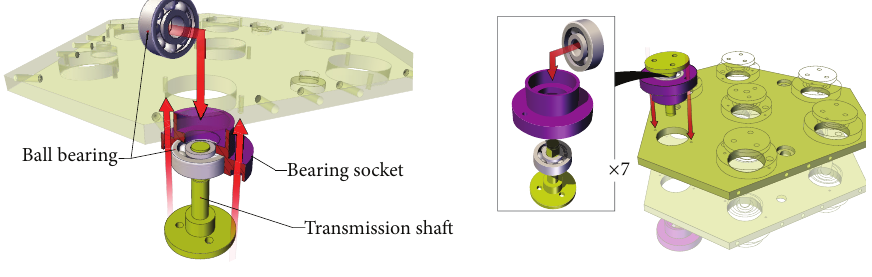
Figure 11: Bearing socket set design.